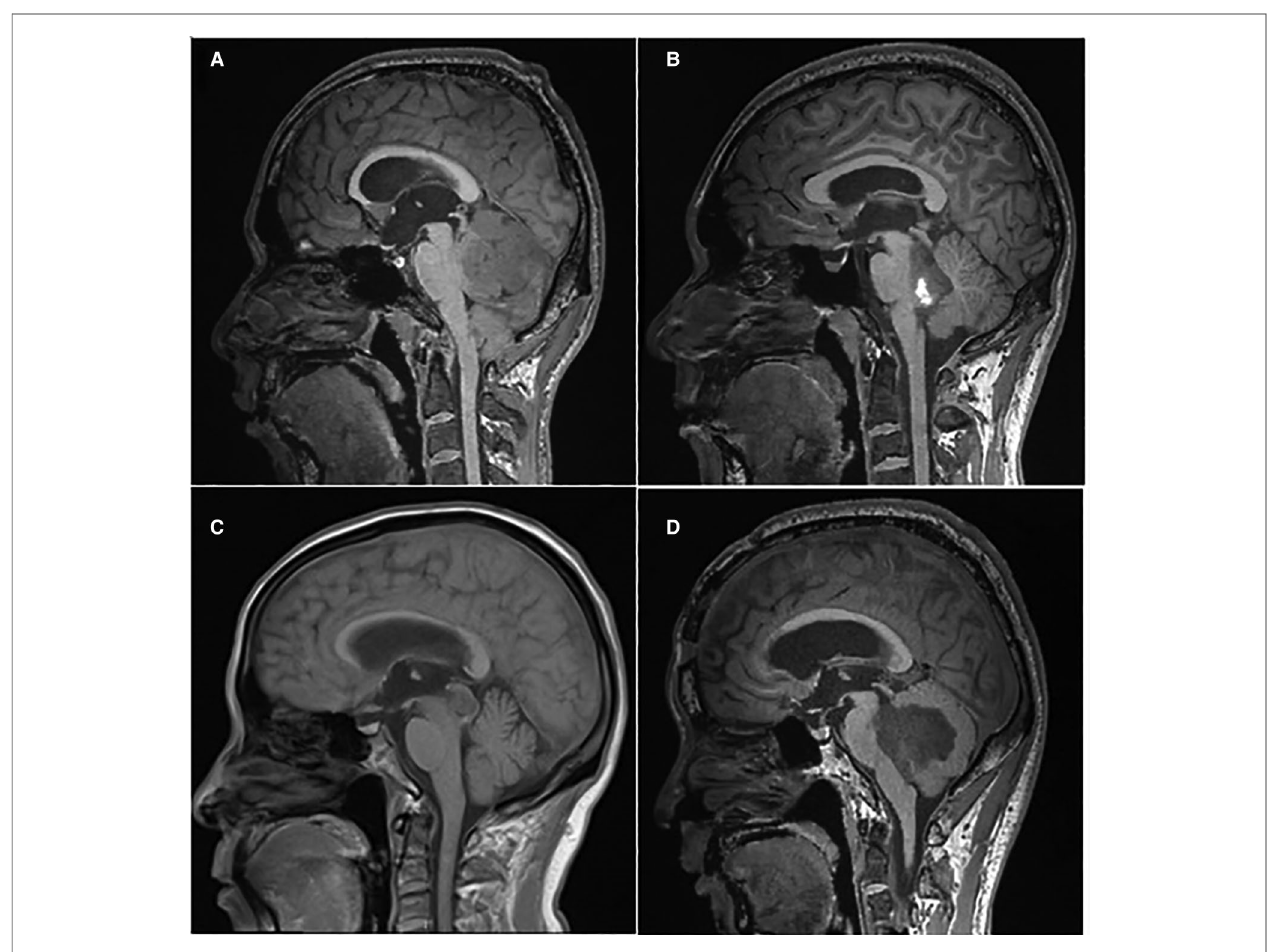
FIGURE 3 | ( A ): sagittal (T1) view of the tumor in fi ltration from the periphery; ( B ): sagittal (T1) view of the tumor in fi ltration from below; ( C ): sagittal (T1) view of the tumor endogenous from the ventricular system; ( D ): sagittal (T1) view of the tumor in fi ltration of the upper half of the fourth